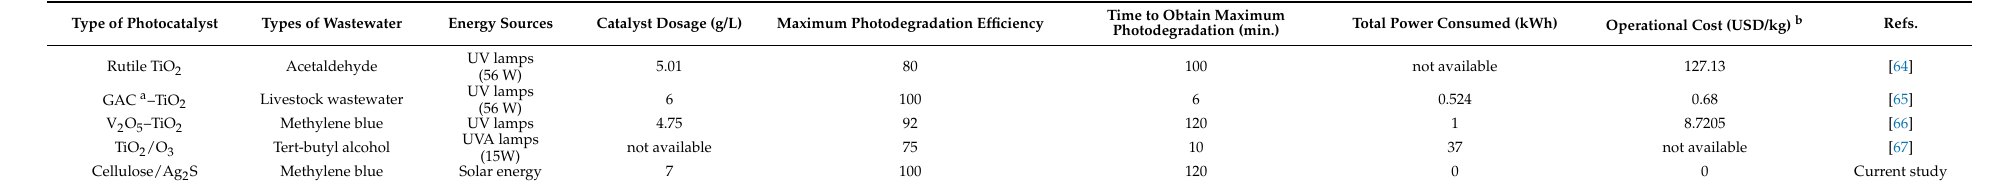
Table 1. Comparison of the cost-effectiveness assessment of several